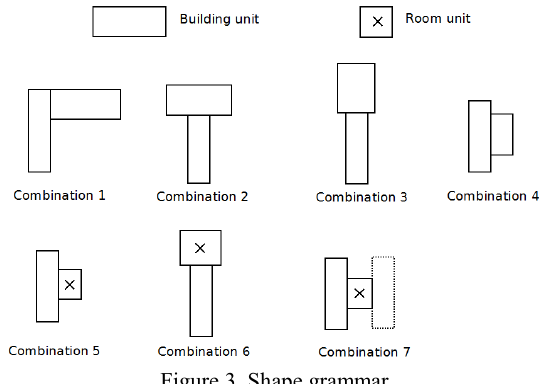
Figure 3. Shape grammar